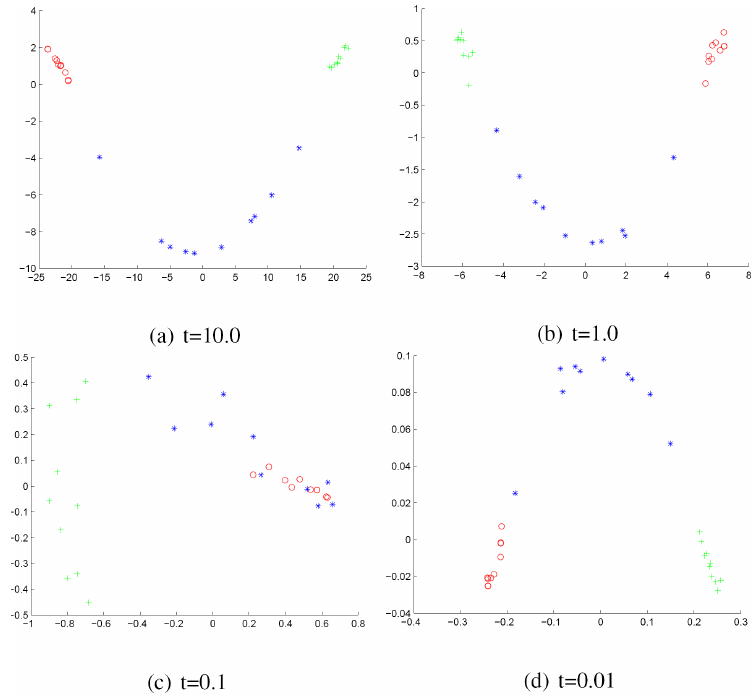
Figure 2. Multidimensional scaling (MDS) embedding obtained using Hausdorff distance (HD) for house data represented by the sectional curvatures residing on the edges. The x and y axes are the embedding coordinates corresponding to the leading two dimensions of the MDS embedding. The differently-coloured symbols denote different object